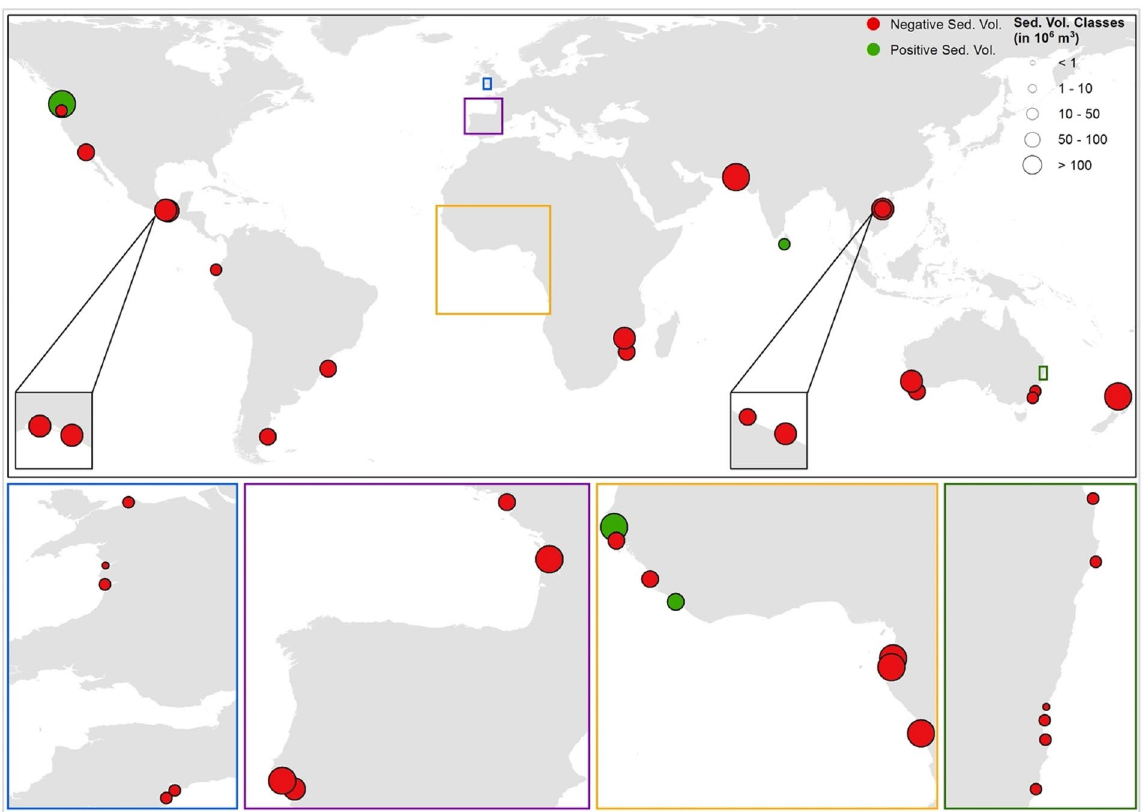
Figure 2. The projected change in the time-averaged 50th percentile values of the total sediment volume exchange ( (cid:31) V T ) between the estuary system and the adjacent coast at 41 catchment-estuary-coastal systems around the world, over the 2091–2100 period under RCP 8.5. Negative and positive values of (cid:31) V T